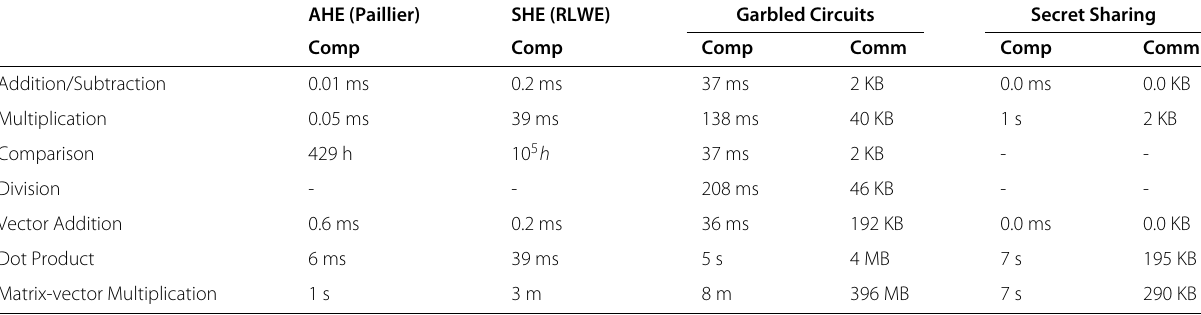
Table 1 Real cost comparison for confidential arithmetic and linear algebra operations at 112-bit security, v 100 × 1 and M 100 ×